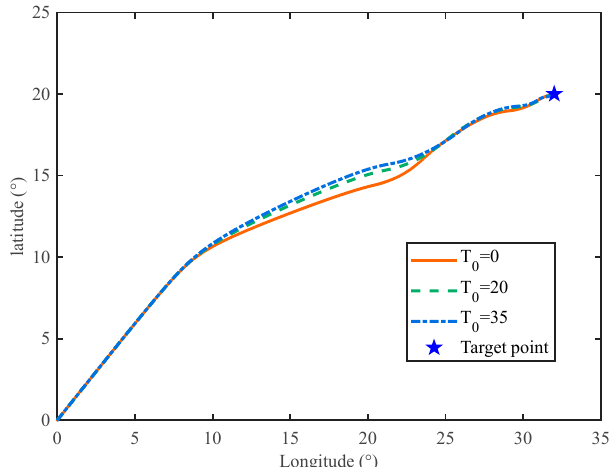
Figure 9. Latitude and longitude changes.